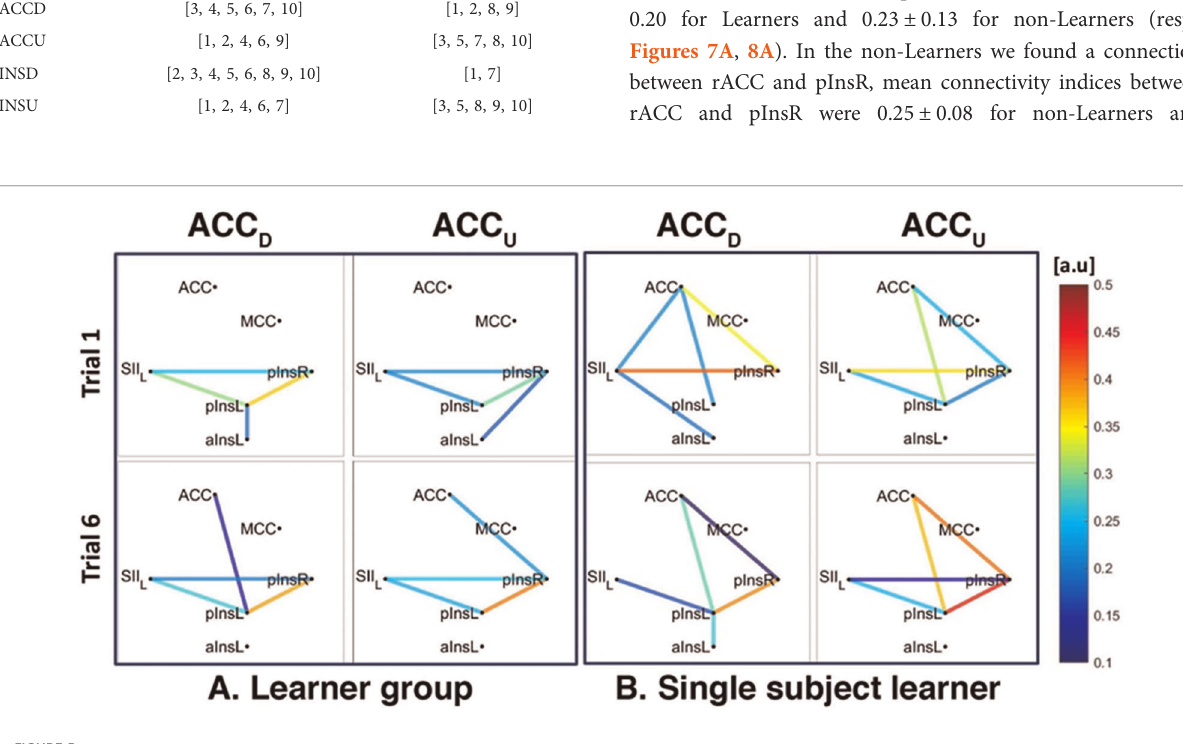
FIGURE 5 Connectivity strengths identi fi ed using the Coherence analysis for the ACC condition (ACC D , ACC U ) in the Learner group ( A ) and for a representative Learner ( B ) in the fi rst trial (Trial 1, top) and in the last trial (Trial 6, bottom). The colours from blue to red indicate weak to strong connection strength and are expressed in arbitrary units